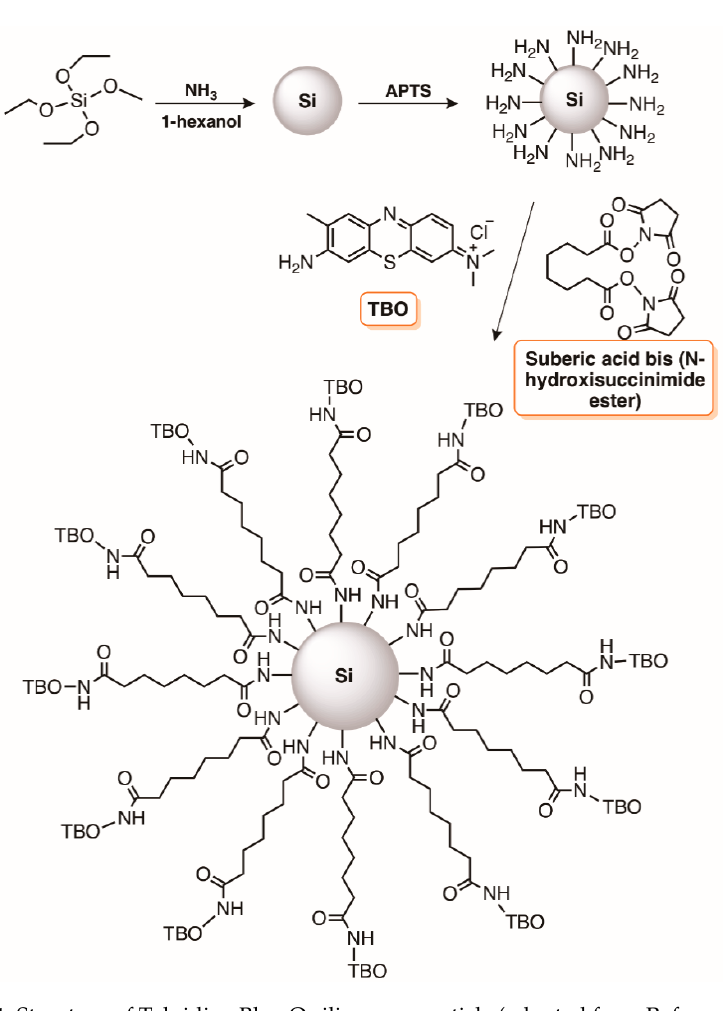
Figure 14. Structure of Toluidine Blue O silica nanoparticle (adapted from Reference [103]).